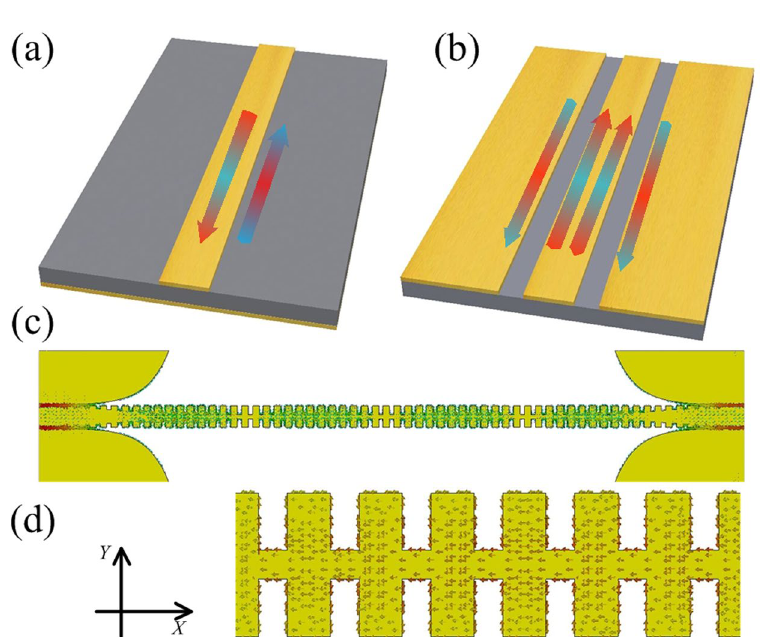
Figure 4. Radiation loss from different parts of the SPP TL.